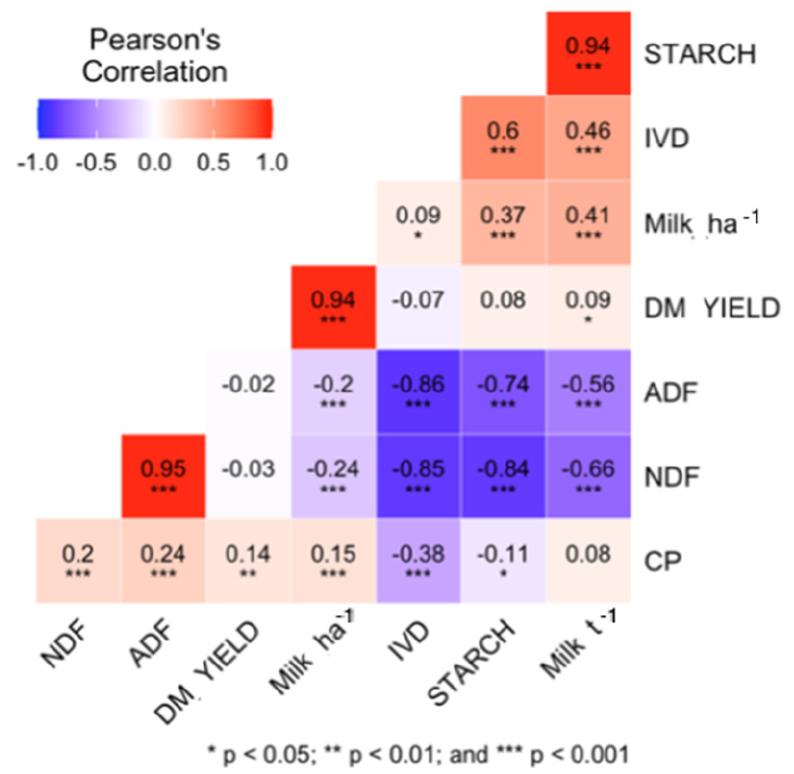
Figure 1. Pearson’s correlation coefficient plot of the quality traits in the dataset; Milk ha − 1 is yield of milk per ton of silage dry matter in kg Mg − 1 ; Milk ha − 1 is yield of milk per ha of maize silage crop; DM_YIELD is the genotype dry matter yield per